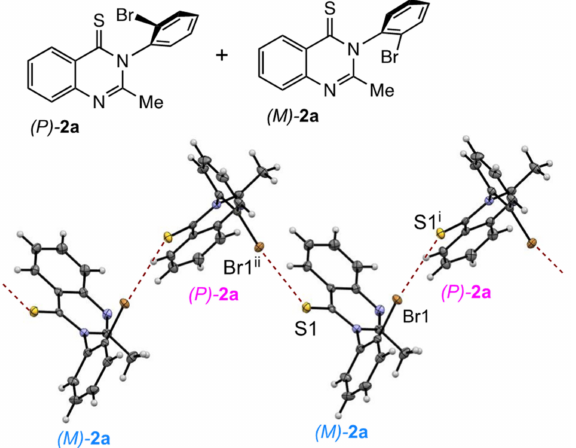
Figure 3. A part of packing structure of racemic 2a at 100 K with 50% probability thermal ellipsoids. Symmetry operations: (i) 1/2 − x, 1/2 + y, z, (ii) 1/2 − x, − 1/2 + y,